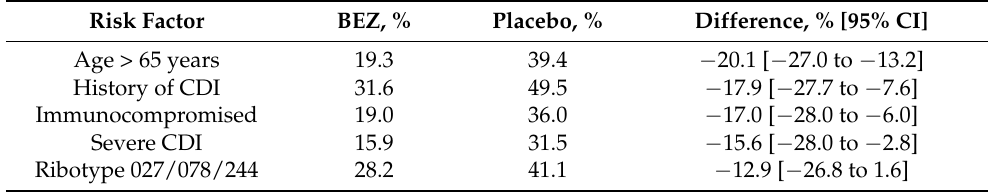
Table 2. Rates of rCDI in patients with pre-specified risk factors [34]. Risk Factor BEZ, % Placebo, % Difference, % [95% CI] Age > 65 years 19.3 39.4 − 20.1 [ − 27.0 to − 13.2] History of CDI 31.6 49.5 − 17.9 [ − 27.7 to − 7.6] Immunocompromised 19.0 36.0 Severe CDI 15.9